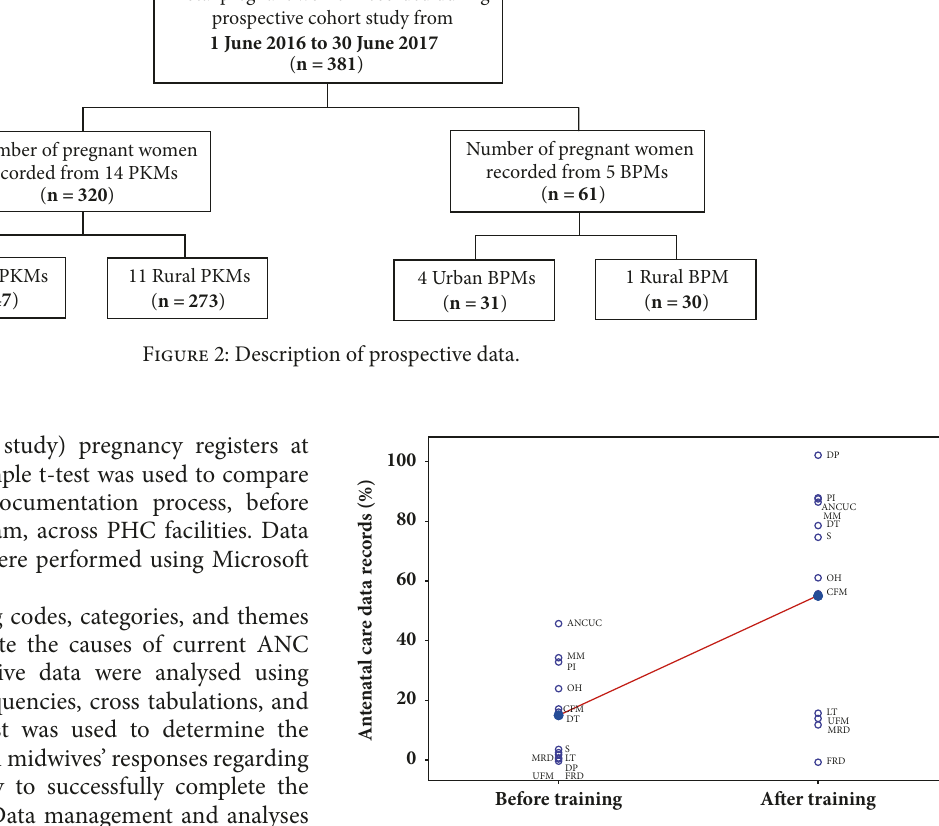
Figure 3: Individual plot of average ANC data records (%) before and after midwives’ training across urban and rural PHC